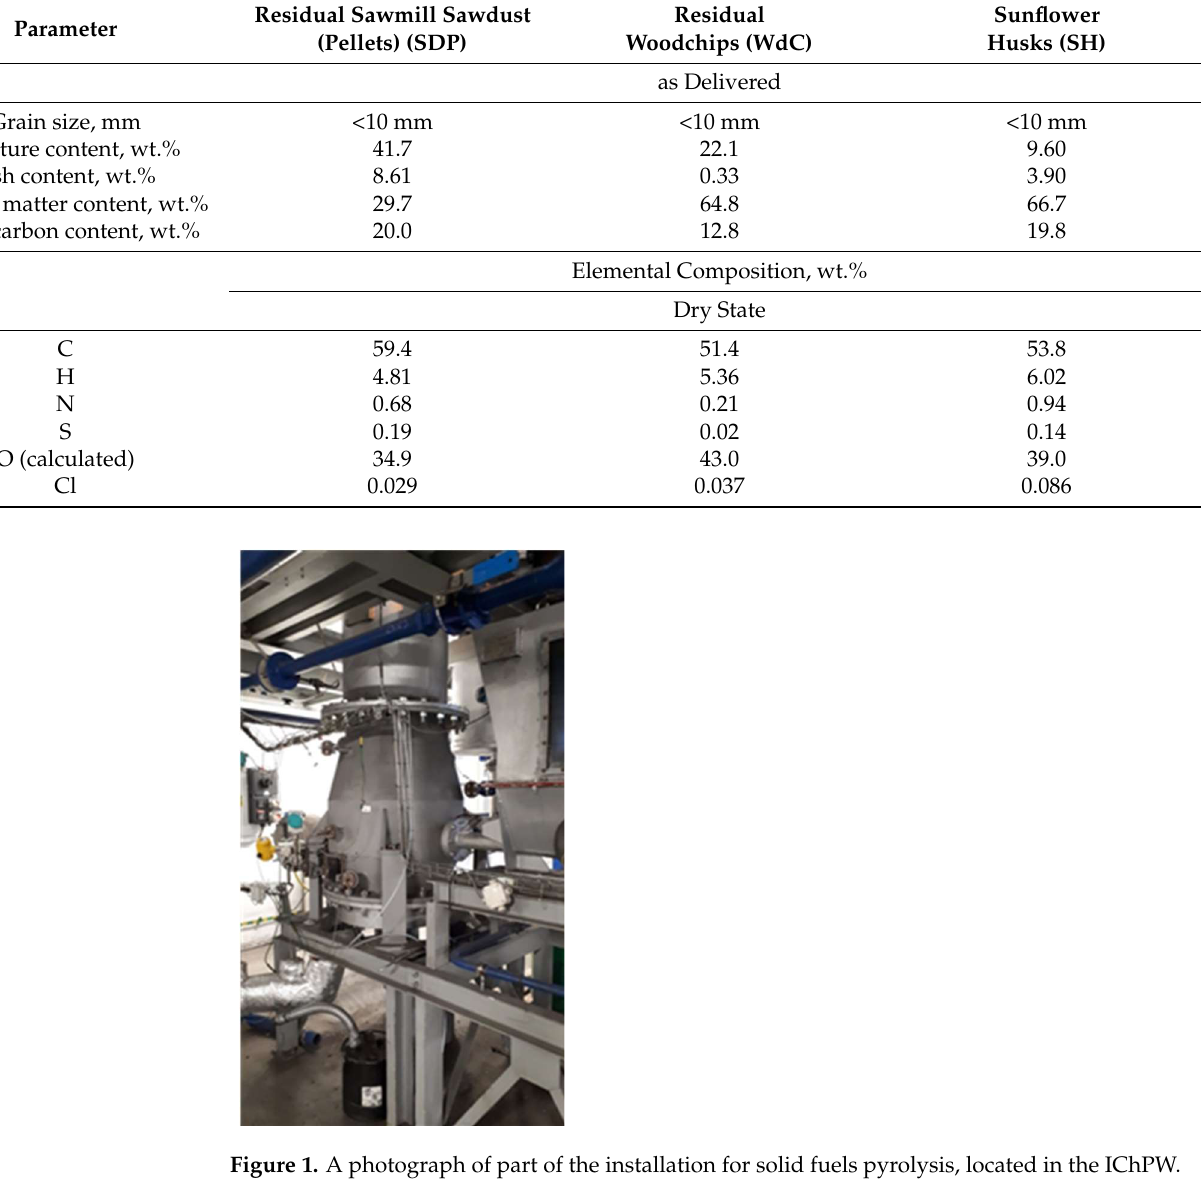
Table 1. Characteristics of feedstock biomass materials used in the research.